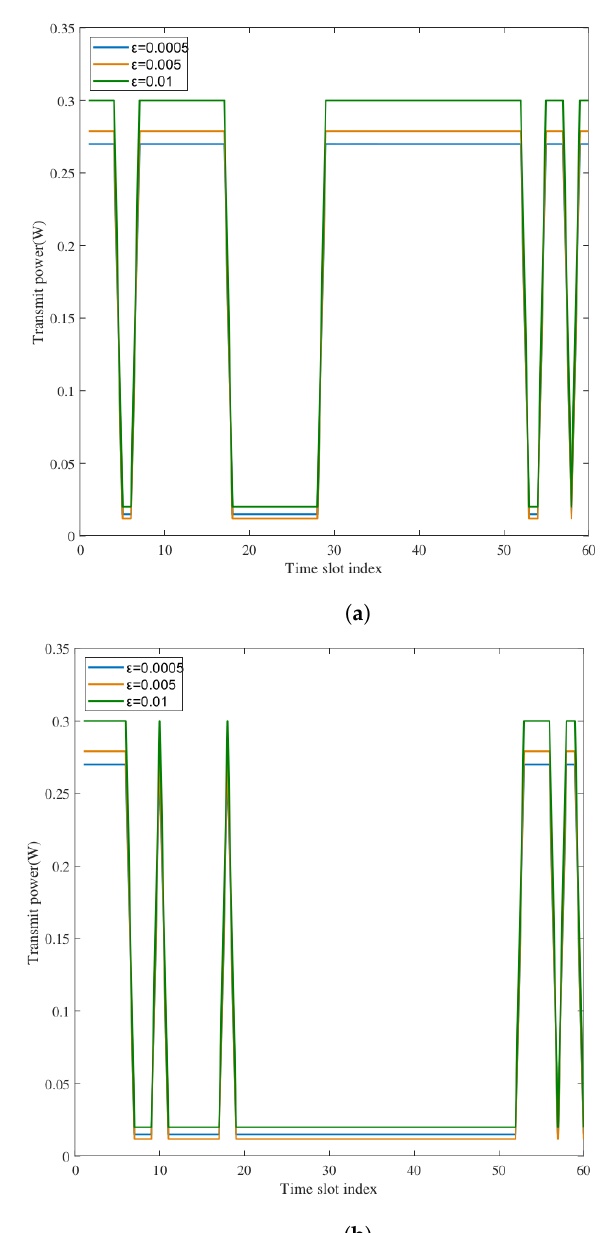
Figure 5. The UAVs’ transmit power for different coverage constraints. ( a ) UAV1 transmit power; ( b ) UAV2 transmit